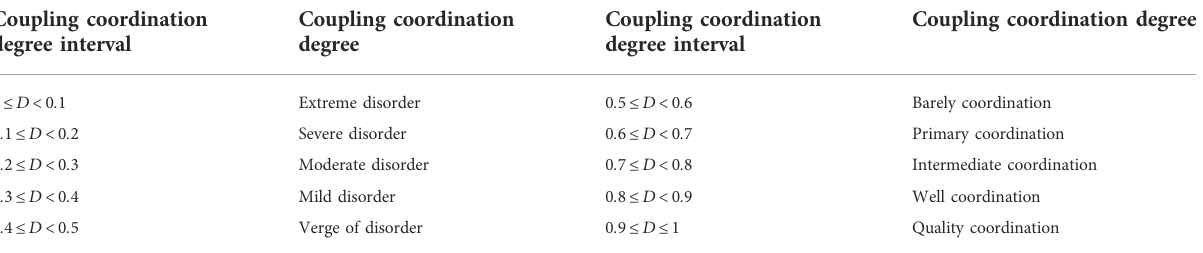
TABLE 1 Classi fi cation of the coupling coordination